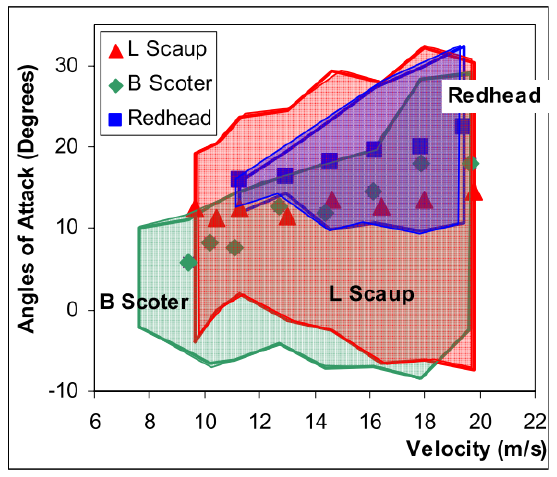
Figure 11. Regions with different colors represent the testing condition under which any alula deflection was observed; points represent the condition where the alula had maximum deflection [27].